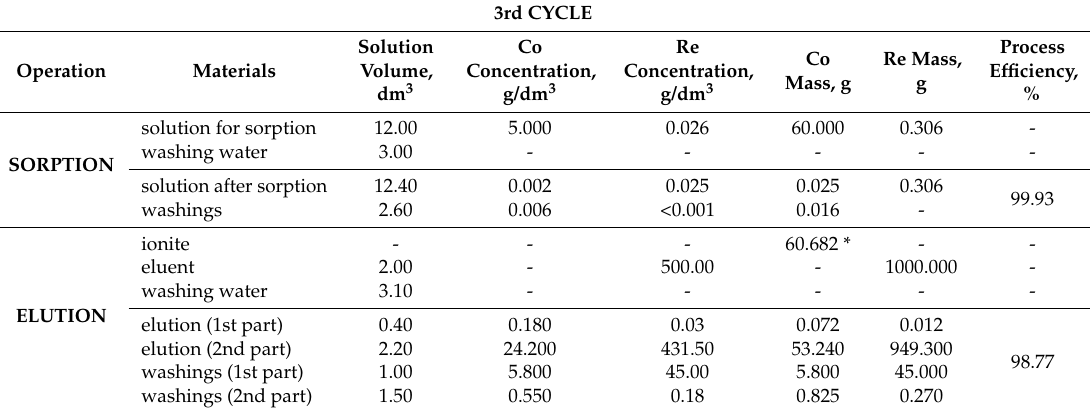
Table 10. Balance for cobalt(II) sorption and elution—3rd cycle. 3rd